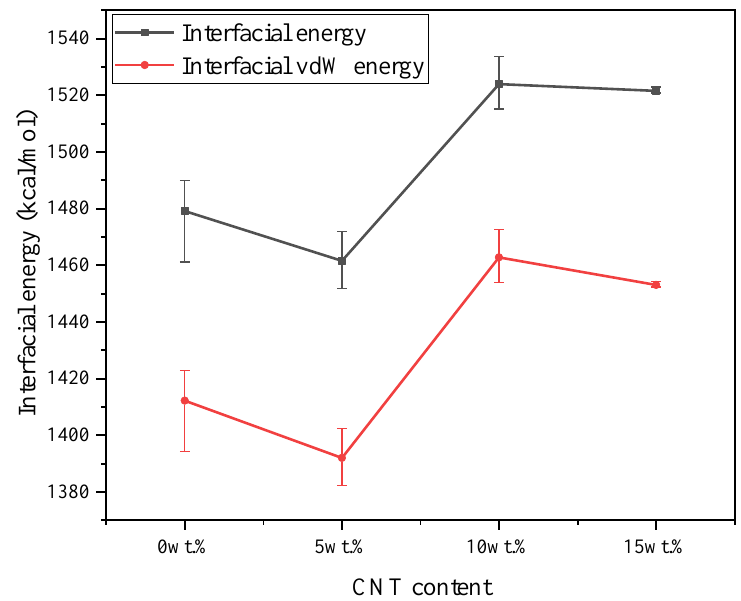
Figure 8. The energy of composite-SiO 2 interface.